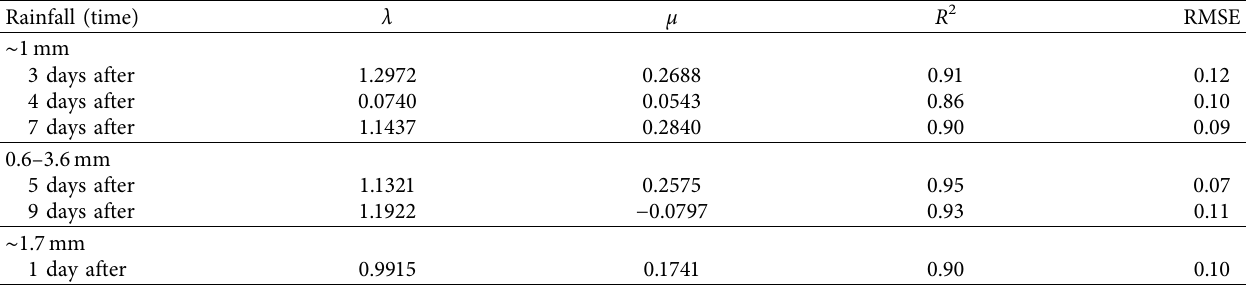
Table 2: Performance of equation (3) with weathering parameters after